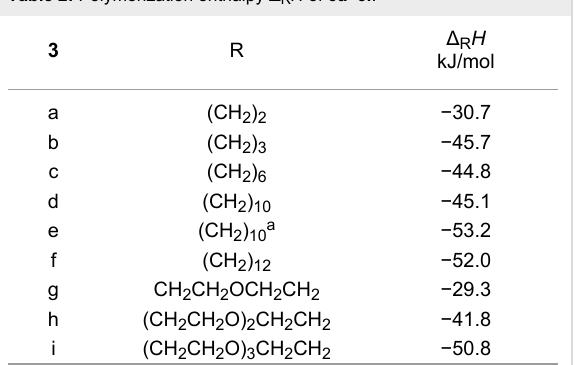
Table 2: Polymerization enthalpy Δ R H of 3a–3i .